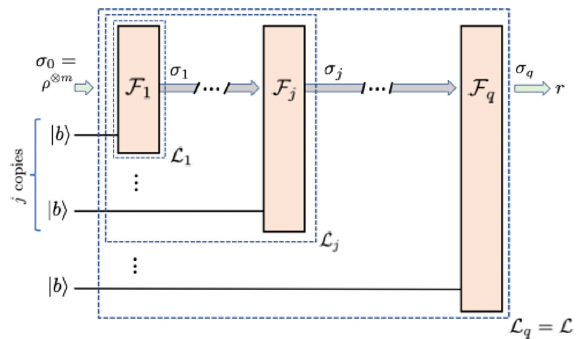
FIG. 2. The quantum operation L of the PM type returned by the QSV protocol on input A . Arrows denote the states σ j output by the quantum operations F j and used as the input to the fol- lowing F j + 1 , together with a fresh copy of | b (cid:3) . The input state to L contains m copies of ρ and q copies of | b (cid:3) . The output state contains the bit r